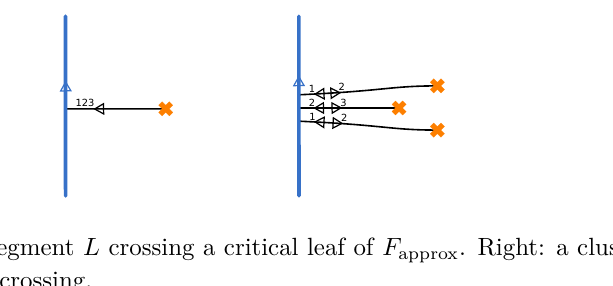
Figure 33 . Left: a non-critical leaf of F approx which is crossed by L at two distinct points. Right: a cluster of 3 exchanges in a neighborhood of the leaf.